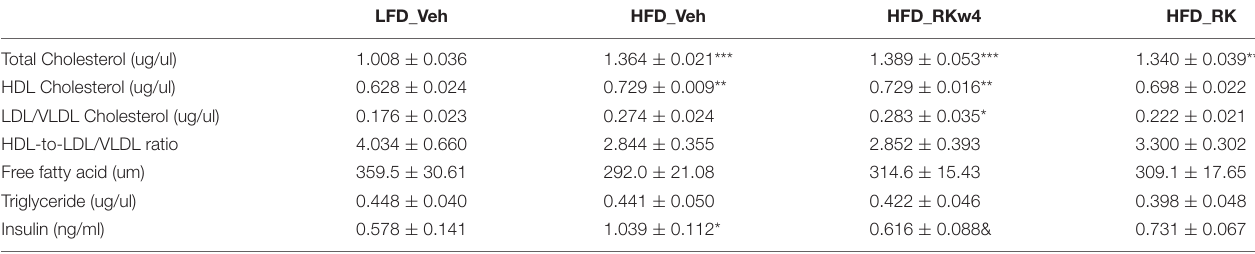
TABLE 2 | Plasma lipid and insulin analysis for mice with RK or vehicle daily dosing for a period of 12 weeks. LFD_Veh HFD_Veh HFD_RKw4 HFD_RK Total Cholesterol